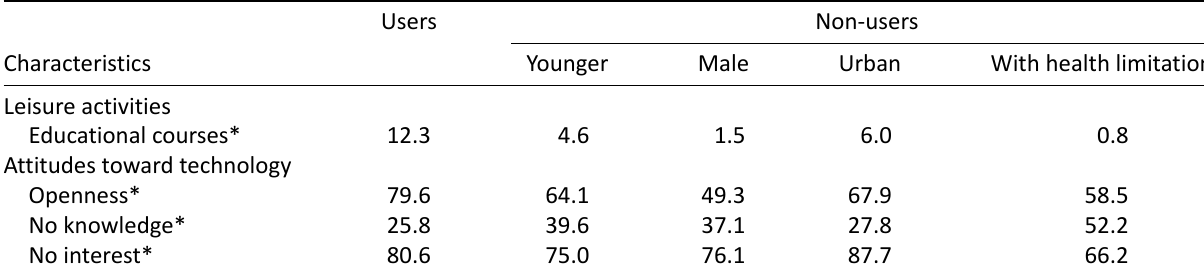
Table 4. Group-specific activities and attitudes toward technology